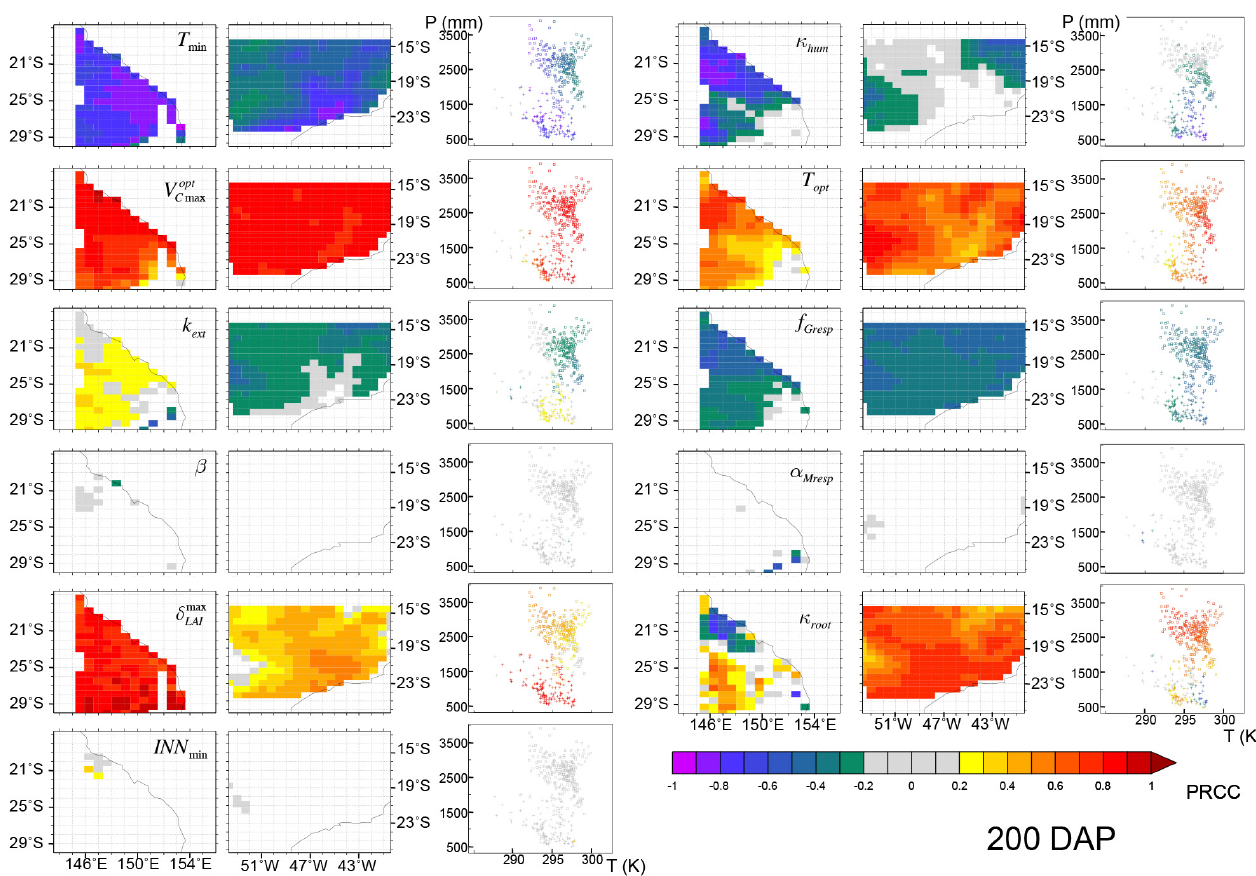
Figure 11. Sensitivity of ORCHIDEE–STICS to its main parameters at 200 days after planting, as measured with partial ranked correlation coefficients (PRCC). The color indicates the strength of the relation between the parameter and the harvestable biomass, which is represented spatially (columns 1 , 2 , 4 , 5) and in a (temperature, precipitation) referential (columns 3 ,